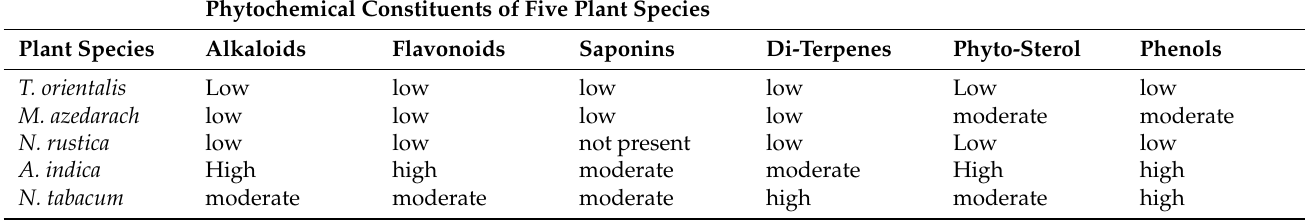
Table 3. Composition of phytochemicals in aqueous extracts of five selected plants